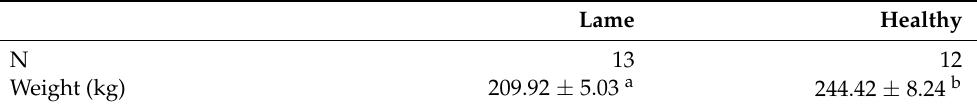
a,b denote significant differences ( p < 0.001). Table 2. Weight at 3.5 years of age of healthy and lamesows. Data are expressed as mean ± s.e.m.